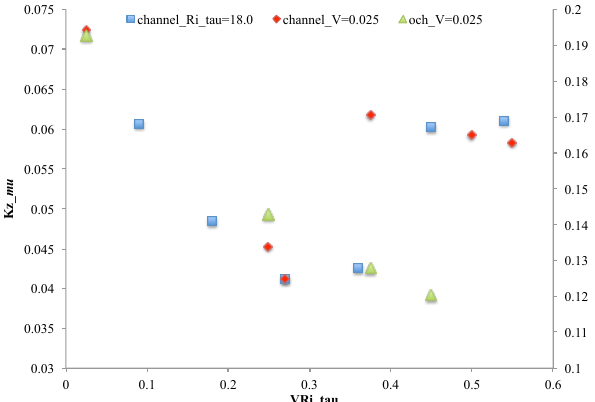
Figure 5. Mean sediment diffusivity ( K zµ ) calculated from all the DNS simulations has been plotted against the corresponding level of stratification ( ˜ V Ri τ ) . K zµ for the boundary-layer cases (open- channel-like configuration) has been plotted on the secondary y axis. K zµ for the open-channel cases decrease monotonically with increase in stratification ( ˜ V Ri τ ) . The aforementioned trend is not reflected in the channel flow configuration. K zµ for the channel flow configuration has been plotted on the primary y axis, and show a counterintuitive trend of first decreasing, then increasing and then again decreasing with increase in ˜ V Ri τ